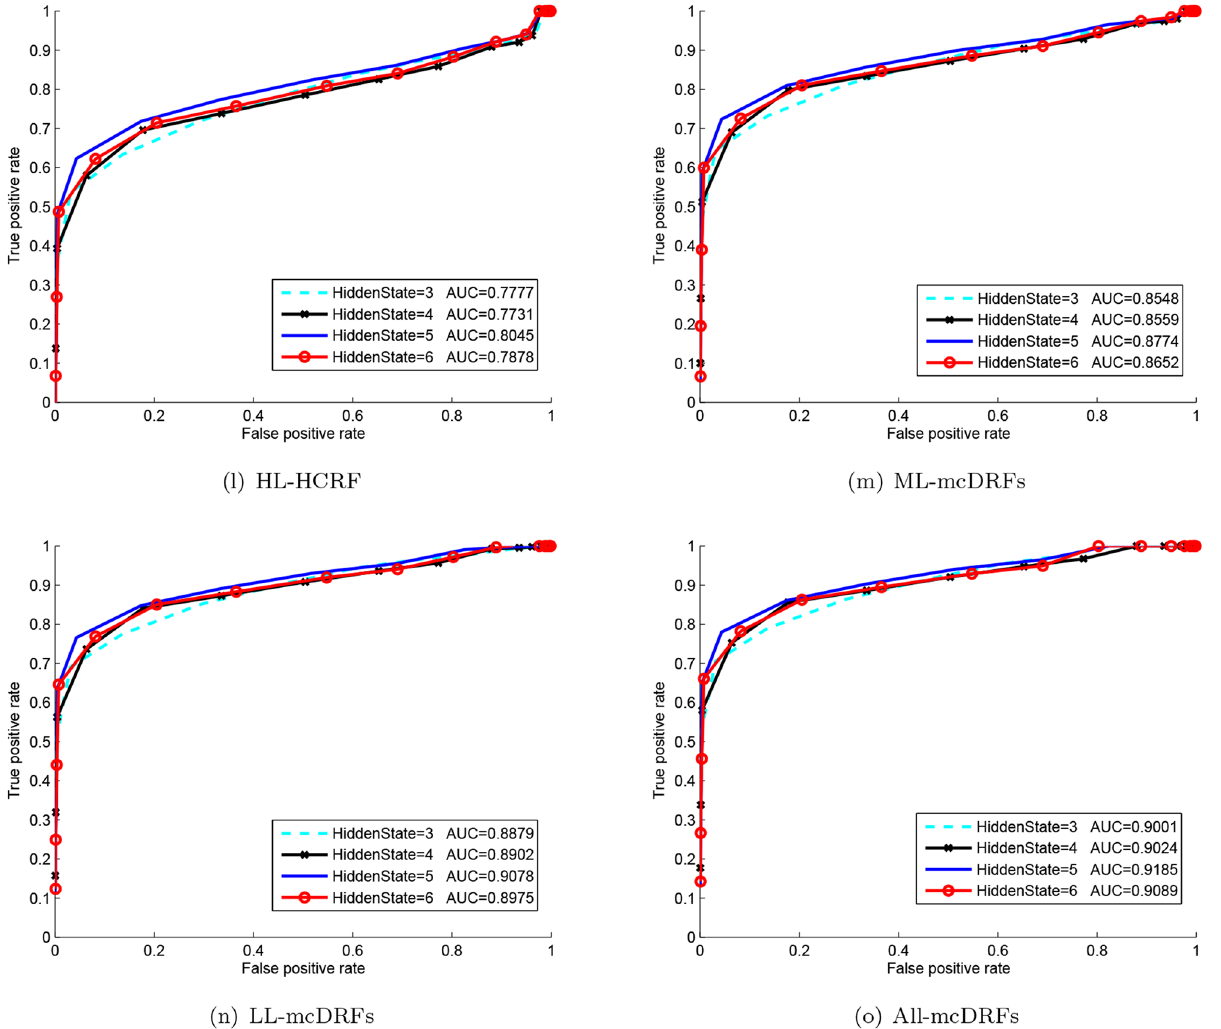
Fig 6. ROC and AUC of MDA with different hidden